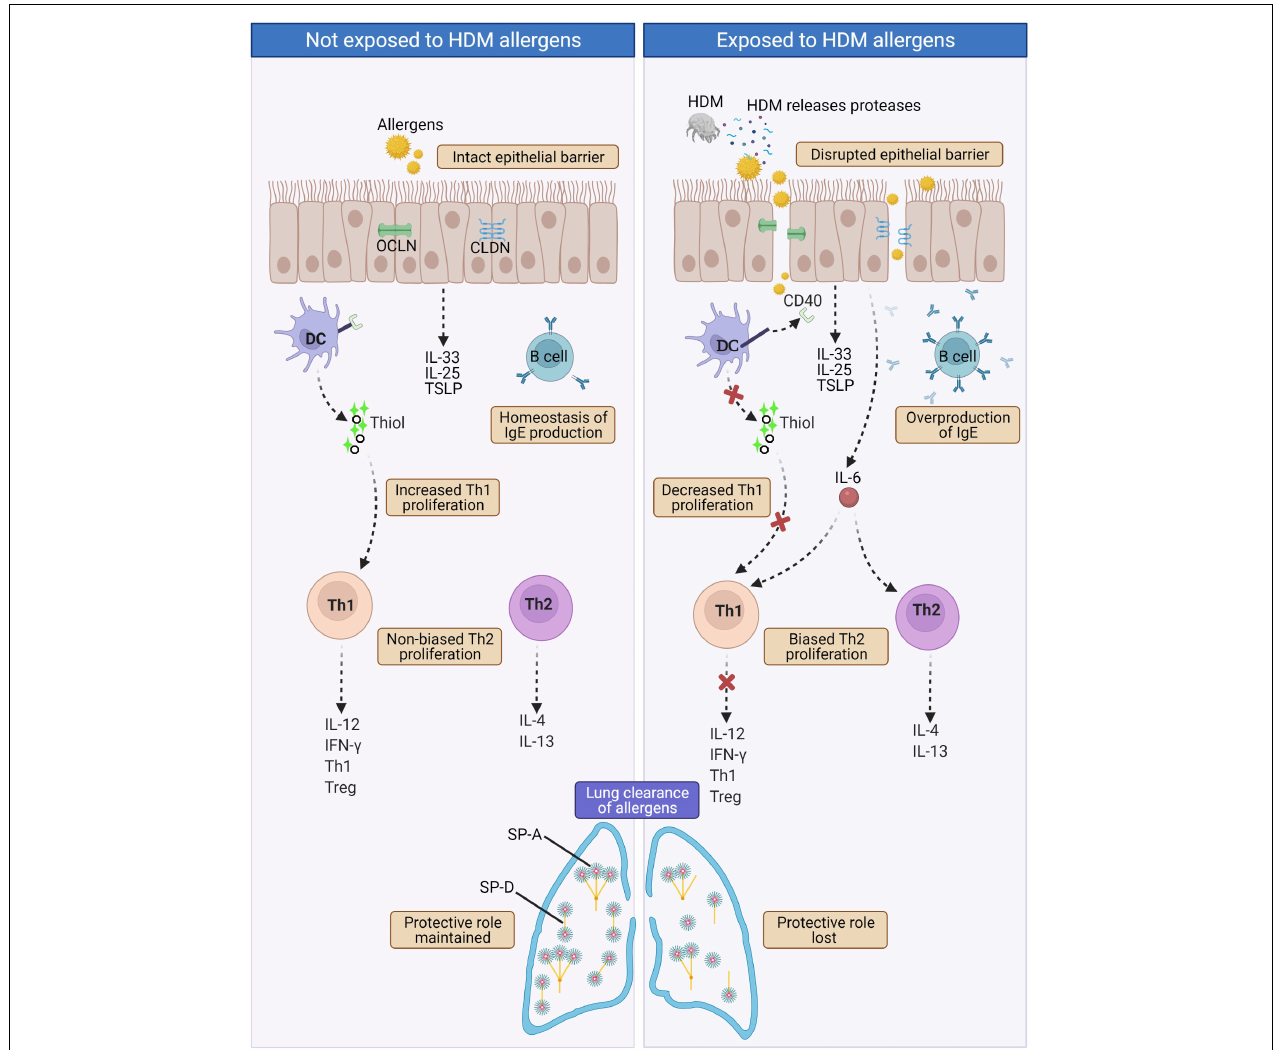
FIGURE 3 | In normal physiological state (left panel), intact epithelial barrier prevents allergens infiltration and hence homeostasis of immune components and functions are maintained. In AR such as HDM-sensitized AR (right panel), proteases released by HDMs disrupt tight junctions leading to disrupted epithelial barrier that allows infiltration of allergens. This triggers a cascade of IgE overproduction by B cells, cleaved CD40 on the surface of DCs disrupts the production of thiols by DCs causing decreased Th1 proliferation and collectively with increased IL-6 secretion leads to biased Th2 proliferation. Th2 cells produce the hallmark AR cytokines IL-4 and IL-13. HDM proteases also cleave the pulmonary surfactants SP-A and SP-D, causing decreased lung clearance of allergens. CLDN, Claudin; DC, Dendritic cell; HDM, House dust mite; IL-4, Interleukin 4; IL-12, Interleukin 12; IL-13, Interleukin 13; IL-25, Interleukin 25; IL-33; Interleukin 33; IFN γ , Interferon gamma; OCLN, Occludin; SP-A, Surface protein A; SP-D, Surface protein D; Th1, T helper type 1; Th2, T helper type 2; Treg, Regulatory T cell; TSLP, Thymic stromal lymphopoietin.